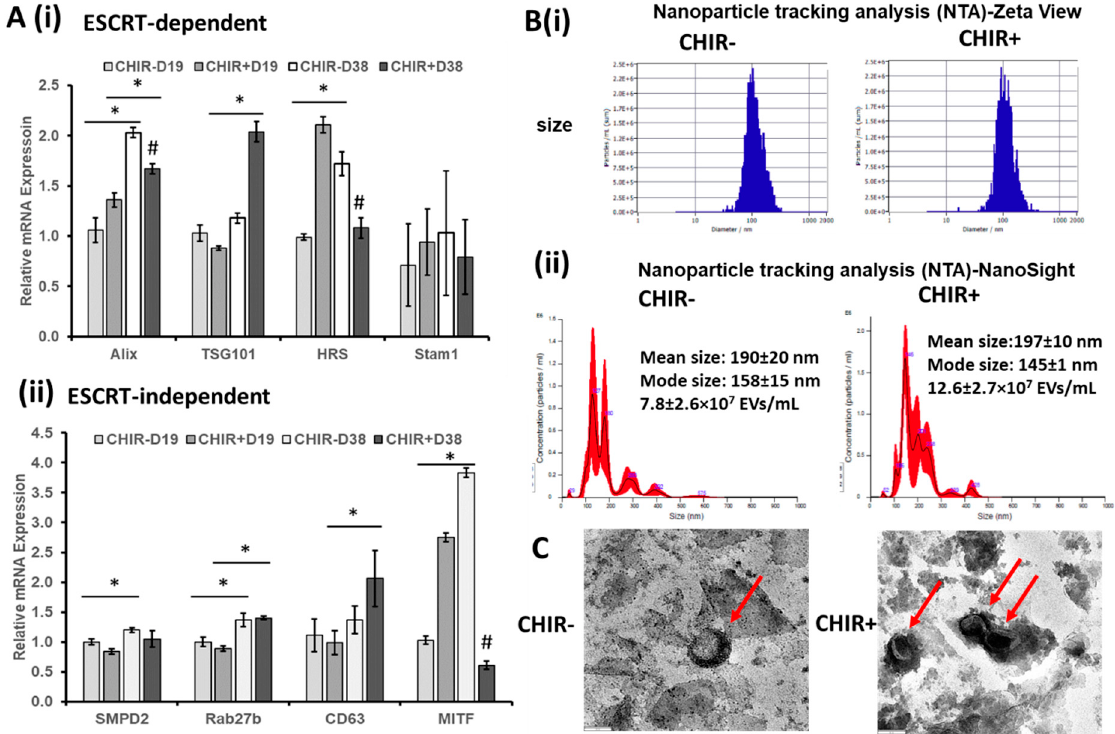
Figure 5. Extracellular vesicle biogenesis of ChP organoids with CHIR+/ − conditions. ( A ) mRNA expression determined by RT-qPCR for (i) ESCRT-dependent EV biogenesis markers; (ii) ESCRT- independent EV biogenesis markers; N = 3. * indicates p < 0.05 for the compared conditions, and # indicates p < 0.05 compared to the CHIR − condition at the same time point. CHIR(+/ − ) indicates treatment with CHIR99021 (3 µM), D19 and D38 indicates days 19 and 38 during di ff erentiation. ( B ) Nanoparticle tracking analysis (NTA) for the isolated ChP organoid-EVs; (i) particle size distribution and zeta potential by ZetaView; (ii) particle size distribution by NanoSight. ( C ) Transmission electron microscopy images showing exosome morphology; scale bar: 100 nm.